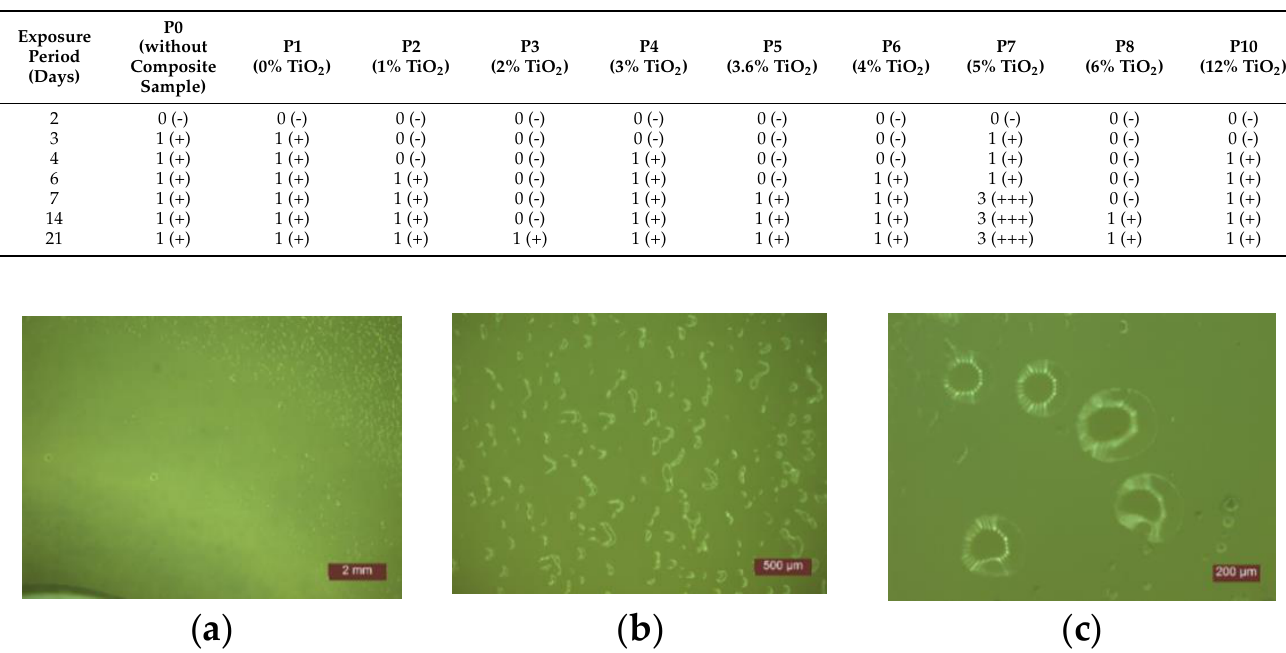
Figure 5. Microscopic examination of the behavior of samples exposed to Staphylococcus Aureus : ( a ) Identification of the inhibition halo area (1:2 mm); ( b ) Growth of colonies (1:500 µ m); ( c ) Detail growth of colonies (1:200 µ m).